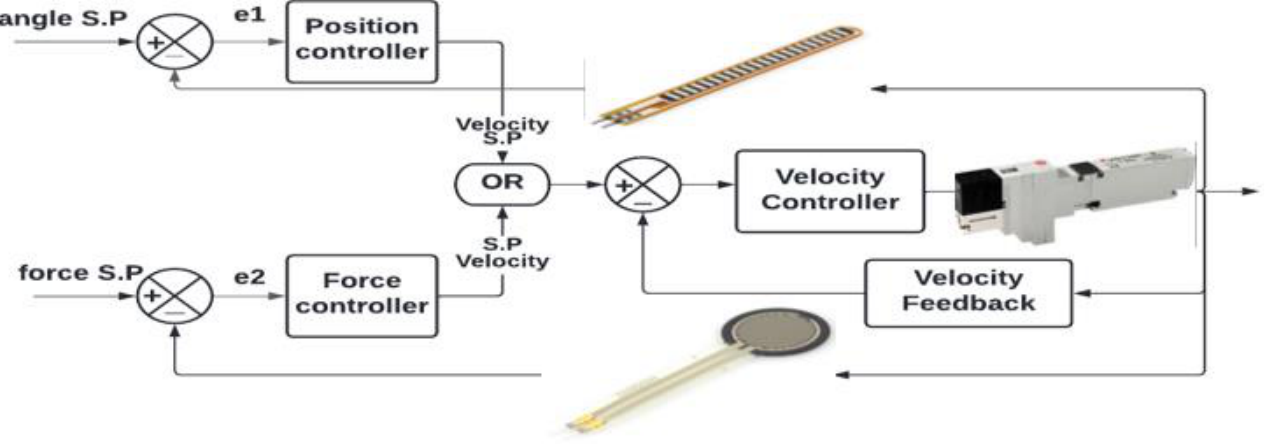
Figure 10. Block diagram to control